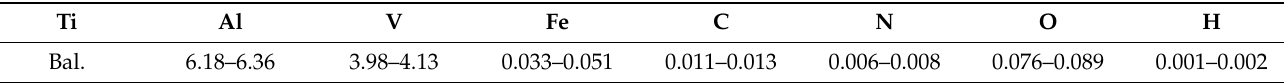
Figure 1. ( a ) Appearance and ( b ) optical microstructure image of Ti-6Al-4V alloy ingot. Table 1. Chemical composition of Ti-6A-4V alloy (wt.%).